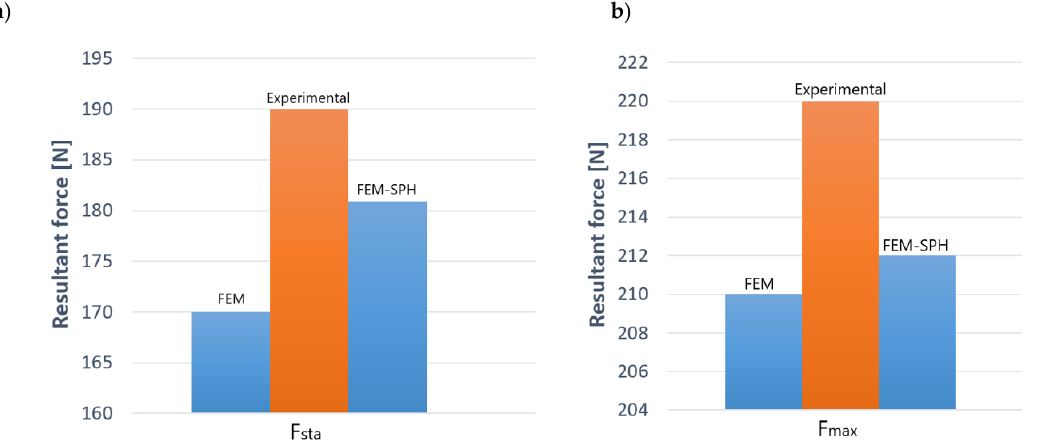
Figure 14. Equivalent plastic strain on sheared edge for h c = 0.06 mm (FEM + SPH model).